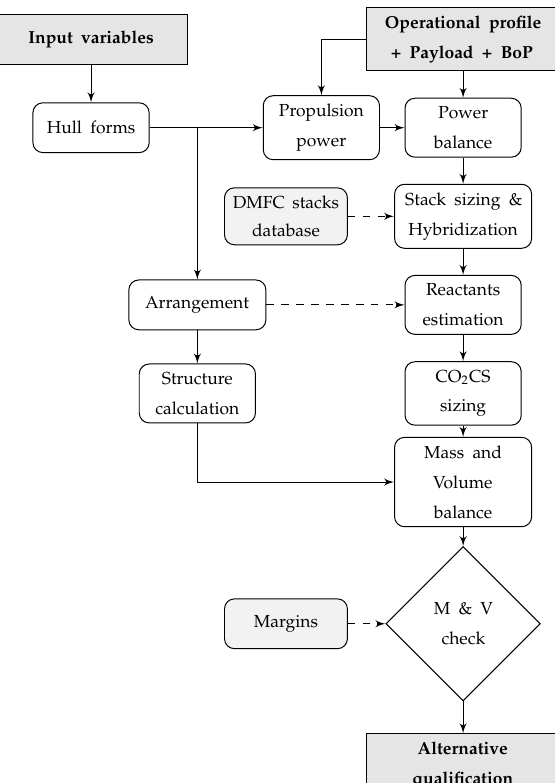
Figure 1. Alternatives design flowchart. BoP, Balance of Plant. DMFC, Direct Methanol Fuel Cell. CO 2 CS, CO 2 Capture System. M & V, Mass and